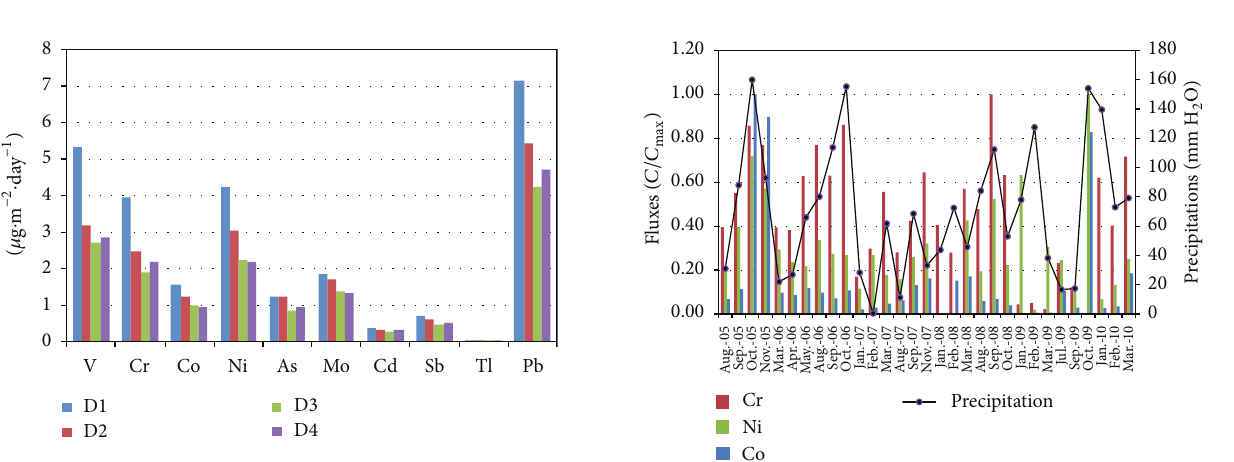
Figure 4: Fluxes of chromium, nickel, and cobalt and precipitations in D4 from August 2005 to March 2010.